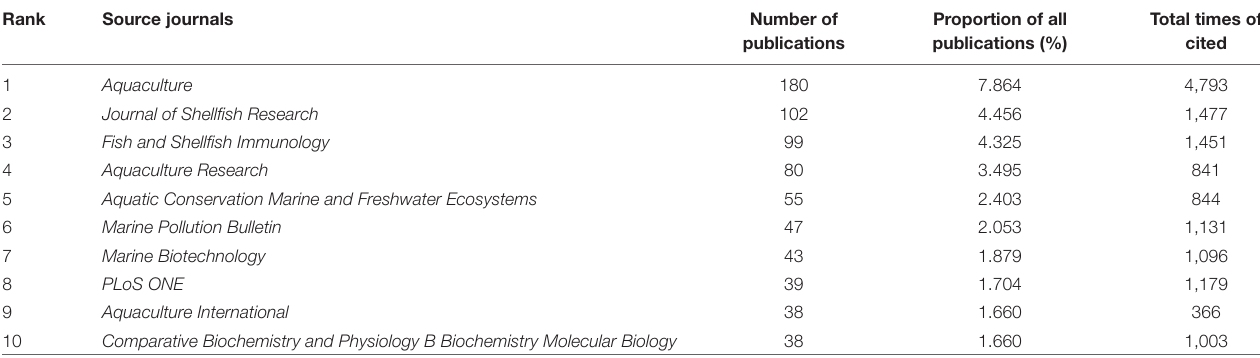
TABLE 1 | Among the studies related with pearl bivalve mollusks as the theme, the numbers of publications, the proportion of all publications, and the total times cited for the top 10 source journals ranked by the number of publications based on Web of Science (WOS).